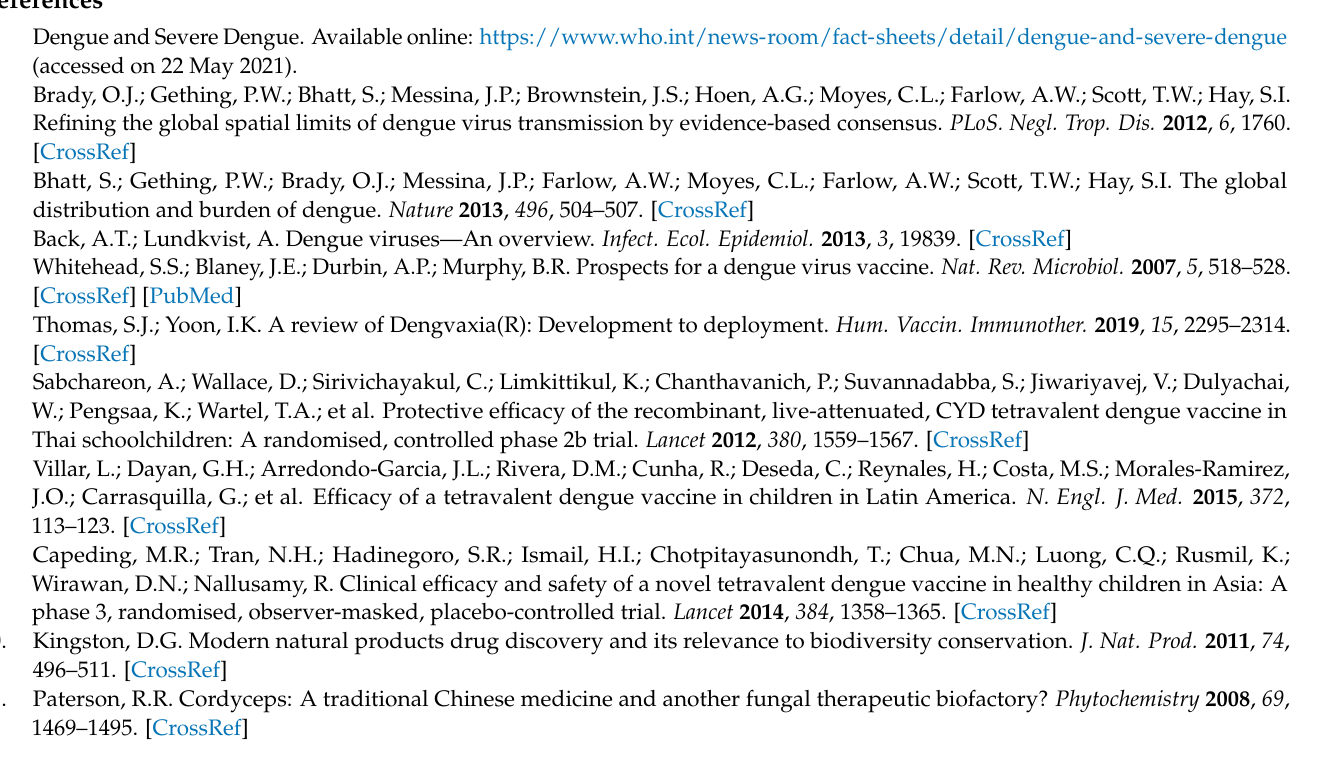
Supplementary Materials: The following data are available: Figure S1: The cell cytotoxicity of cordycepin; Figure S2: The half maximal effective concentration (EC50) of cordycepin on the inhibition of DENV2 infection; Figure S3: Superpositions of residues in binding pocket of X-ray structure and simulated acyl-sulfonamide derivative bound to the N pocket of DENV2 NS5 RNA dependent RNA polymerase (RdRp); Figure S4: The cell cytotoxicity of Cordyceps militaris extract; Figure S5: The schematic diagram of time of addition